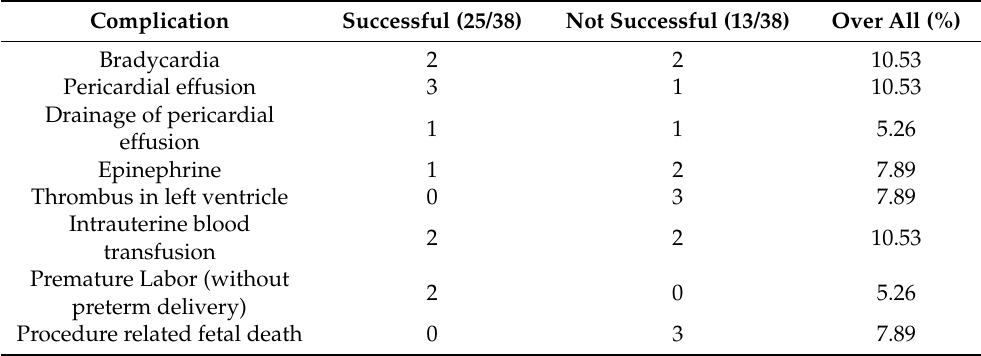
Table 1. Complications of FAV procedures ( n = 38), categorized by technical success.